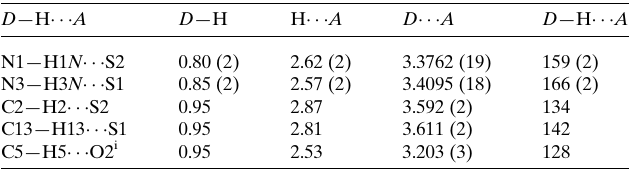
Table 3 Hydrogen-bond geometry (A˚ , (cid:5) ) for (III).